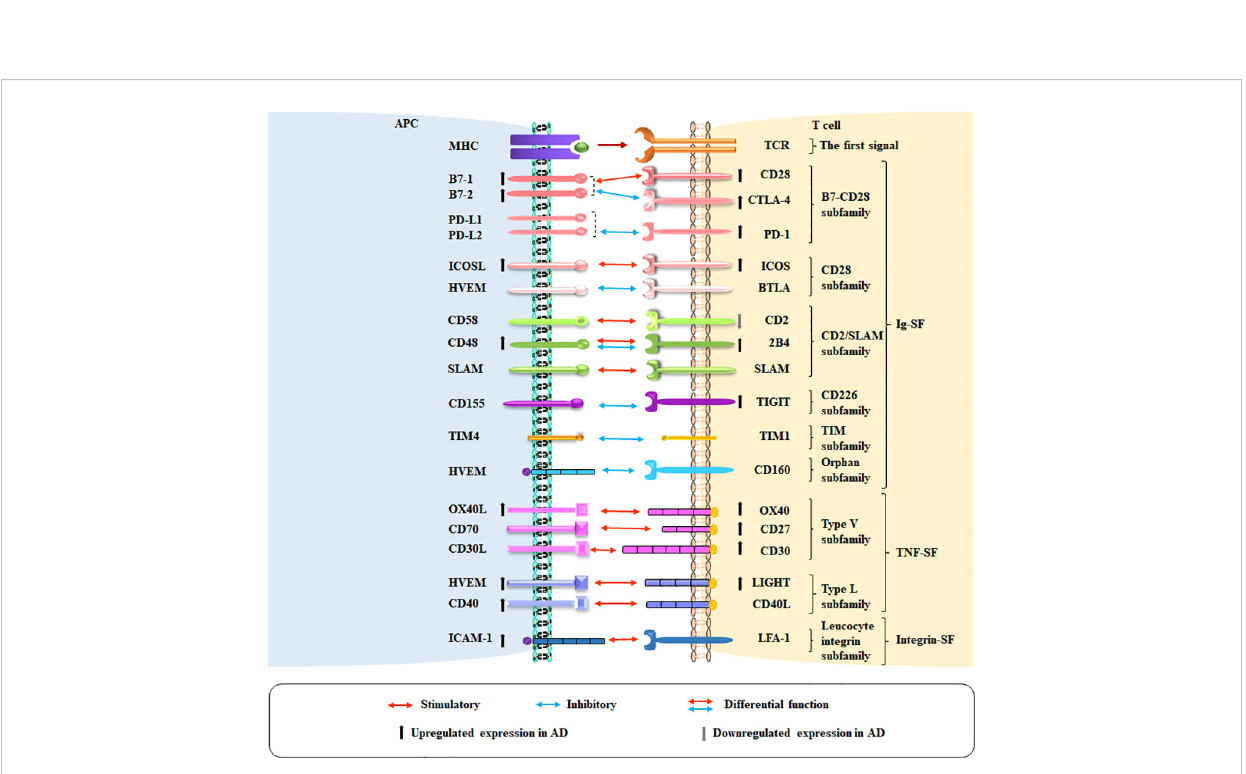
FIGURE 1 Co-stimulatory and co-inhibitory pathways in AD. The co-stimulatory and co-inhibitory molecules on APCs and T cells in AD are shown. Red arrows indicate co-stimulation, blue arrows indicate co-inhibition, and red and blue arrows together indicate molecules with co-inhibitory and co- stimulatory functions. Ascending and descending arrows indicate the increase and decrease of co-stimulatory and co-inhibitory molecules in AD,